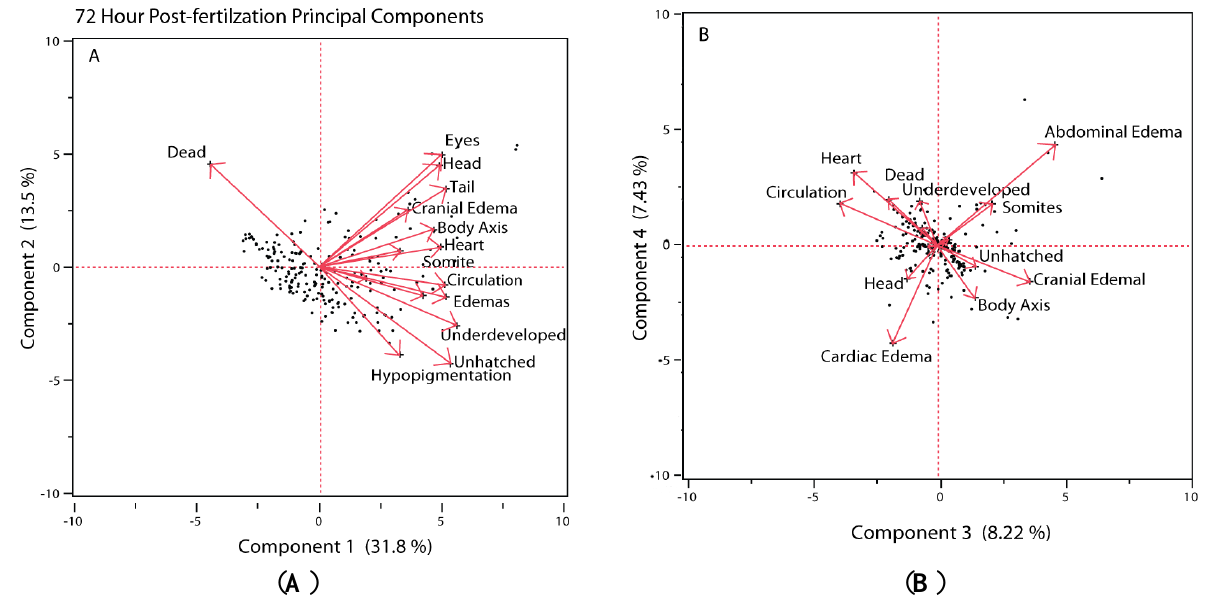
Figure 4. Scatterplots of the scores for pairs of principal components overlaid with a matrix of two-dimensional representations of factor loading of early life-stage endpoints recorded at 72 h post-fertilization. Labeled biplot rays show eigenvectors of endpoints relative to each component in multivariate space. ( A ) X-axis represents component 1 and Y-axis represents component 2. ( B ) X-axis represents component 3 and Y-axis represents component 4.